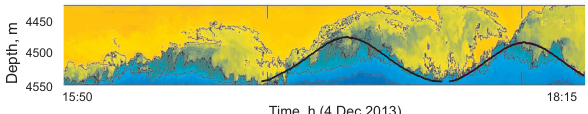
Figure 4. Train of interfacial solitary waves affected by the Kelvin– Helmholtz